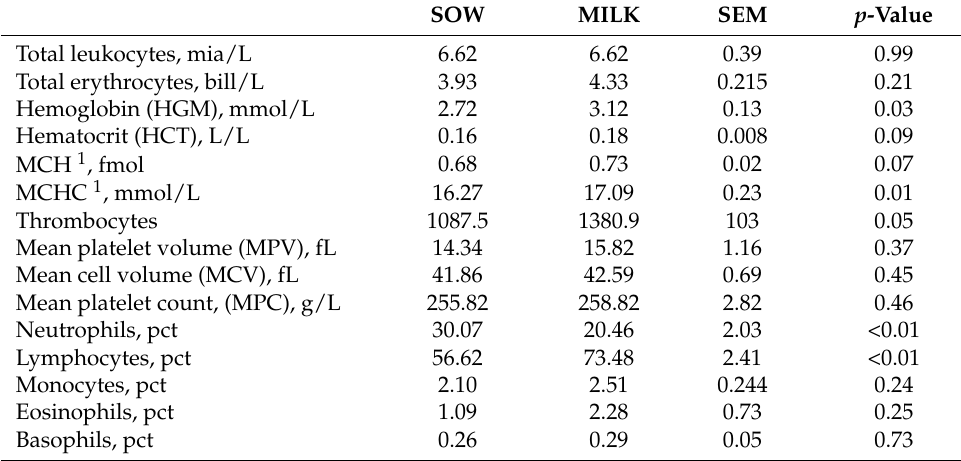
Table 8. The hematology profile of sow (SOW) and artificially (MILK) reared piglets. SOW MILK SEM p -Value Total leukocytes,